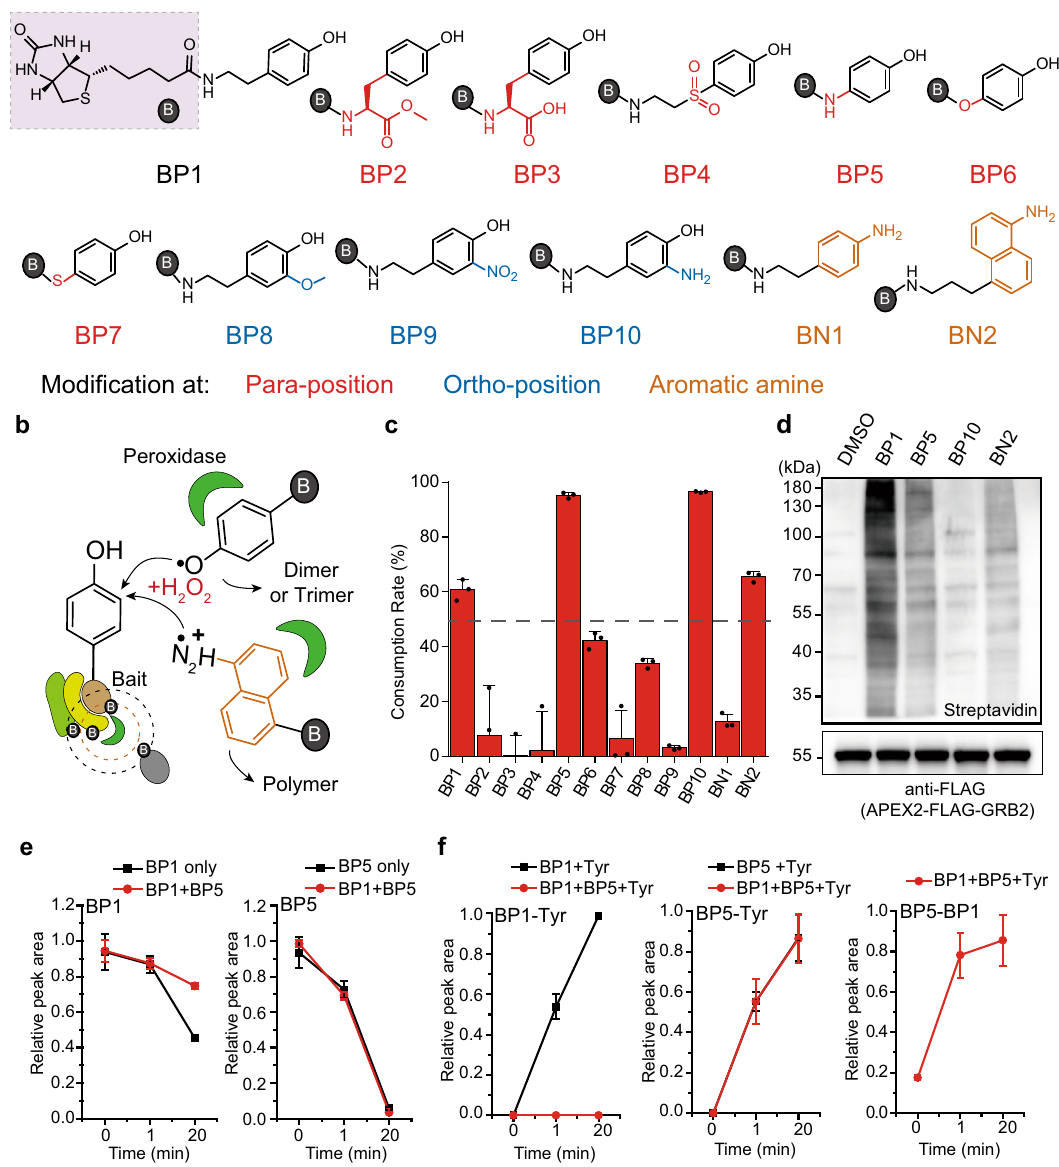
Fig. 1 Design and synthesis of biotin-phenol (BP) derivatives with high reactivity. a Design of different BP derivatives with substituents at para-position (red), ortho-position (blue), and with aromatic amine structures (orange). b Scheme of proximity labeling catalyzed by peroxidases in living cells and in vitro. c Consumption rate of BP derivatives in the presence of 10 nM HRP and 500 μ M H 2 O 2 for 20 min. Each dot represents the indicated data of one independent experiment. Data are presented as mean values± standard divations (s.d.; n = 3 independent biological experiments). d Streptavidin western blot analysis of labeling activity of BP1, BP5, BP10, and BN2 in living HeLa cells with stably expressed APEX2-FLAG-GRB2 fusion protein ( n = 3 independent biological experiments). After incubating the cells with probes for 30 min, 500 µ M of H 2 O 2 was added for 1 min reaction. Quanti fi cation was presented in Supplementary Fig. 12a. e , f Comparison between BP1 and BP5 reactivity with or without tyrosine when incubated together. Data are presented as mean values ± s.d. Error bars in c , e , and f represent s.d. as quanti fi ed by LC-MS ( n = 3 independent biological experiments). Source data are provided as a Source Data fi